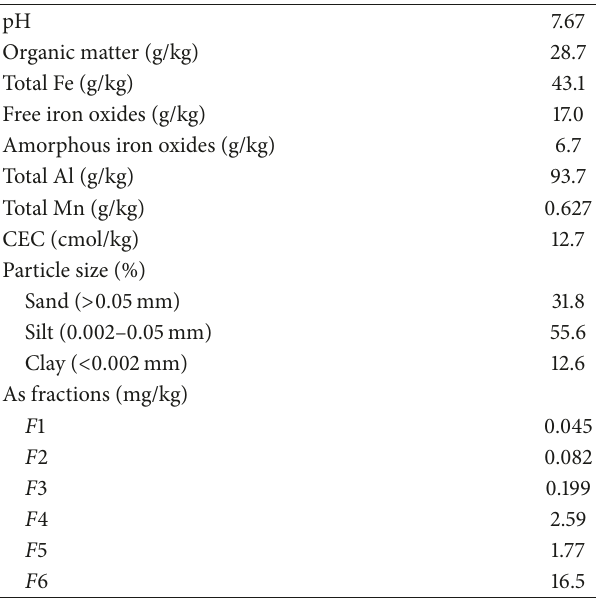
Table 1: Physicochemical properties of the experimental